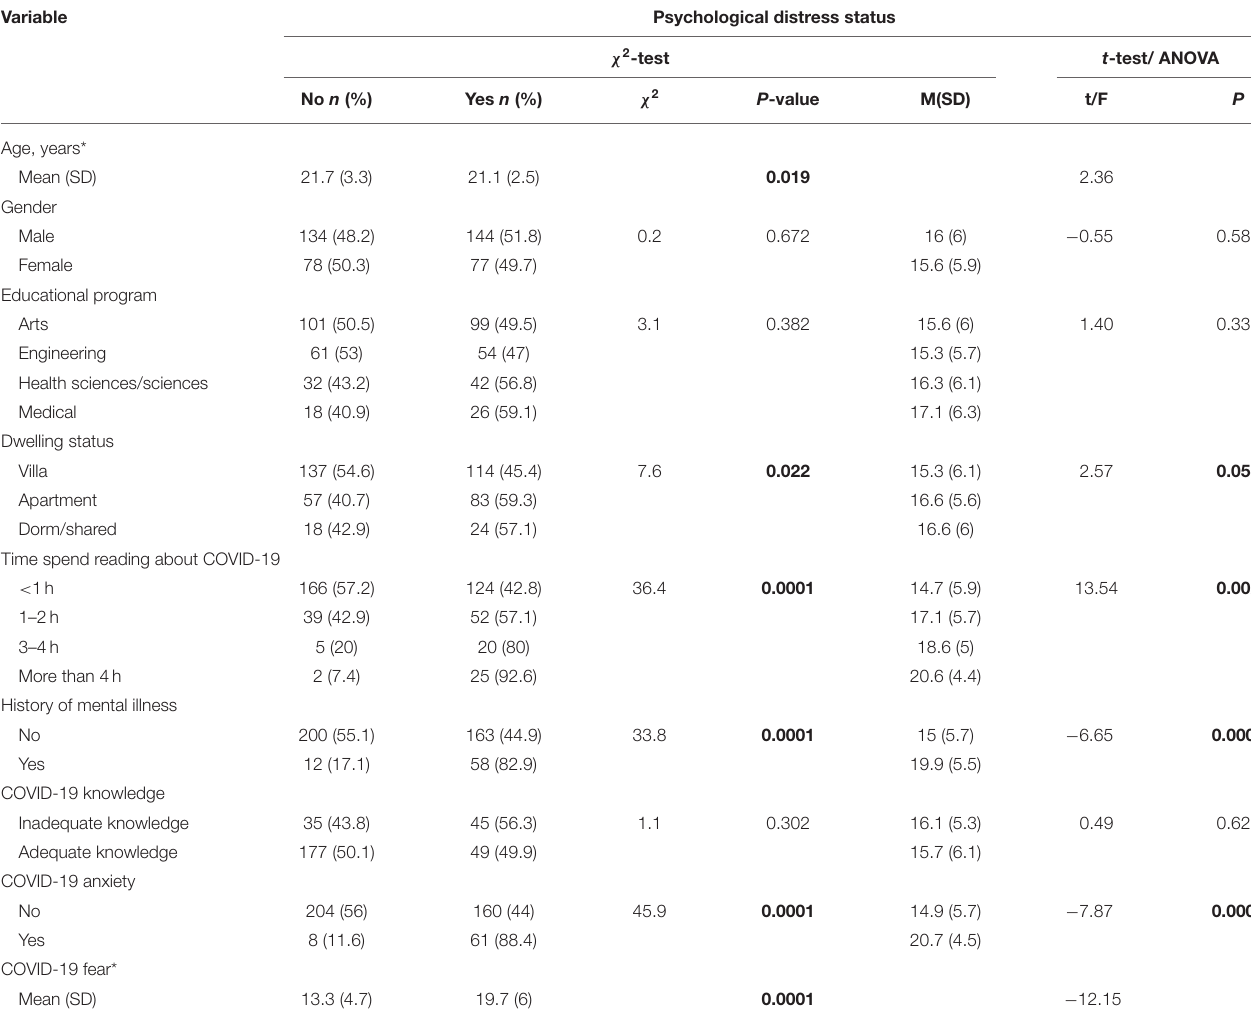
TABLE 4 | Association and differences between psychological distress and demographic variables, knowledge, anxiety, fear. Variable